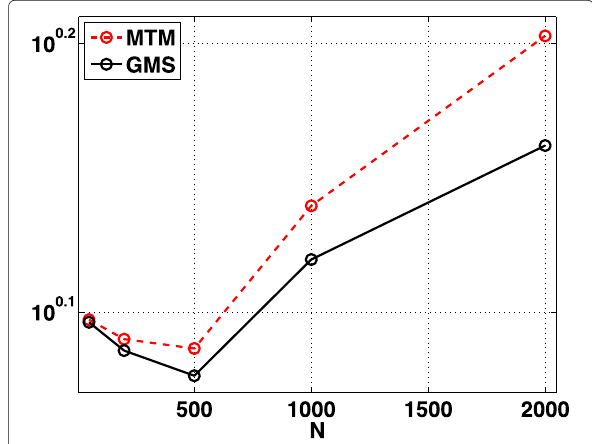
Fig. 7 MSE (log-scale) versus the number of candidates, N ∈ { 50,200,500,1000,2000 } , obtained by GMS and the corresponding MTM algorithm, for the example in Section 6.4. The total number of evaluations of the posterior PDF is fixed to E = MT = 10 4 , so that T ∈ { 200,50,20,10,5